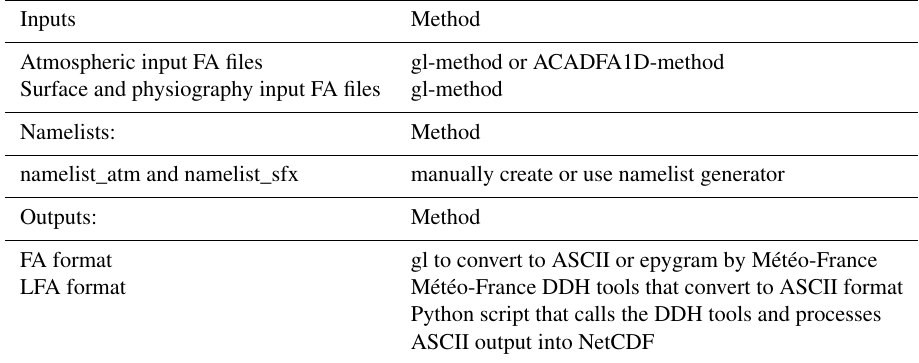
Table 1. MUSC inputs, outputs and